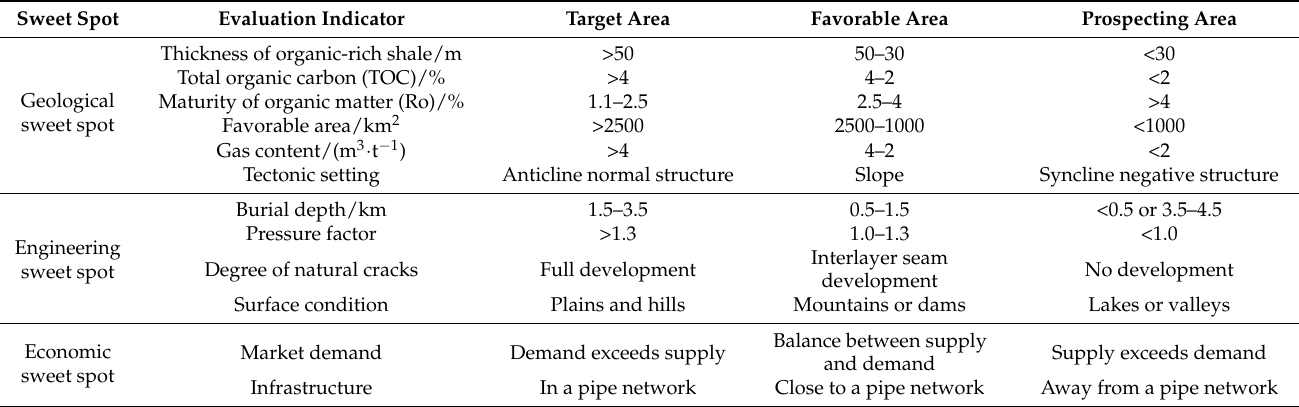
Table 2. Shale-gas evaluation criteria and main